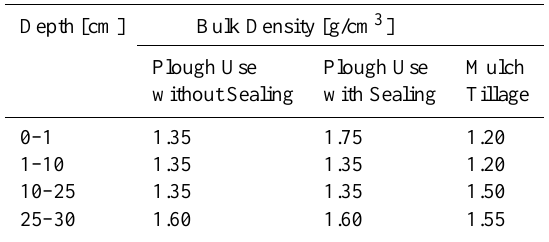
Table 3. Parameterisation of bulk density for different tillage prac-